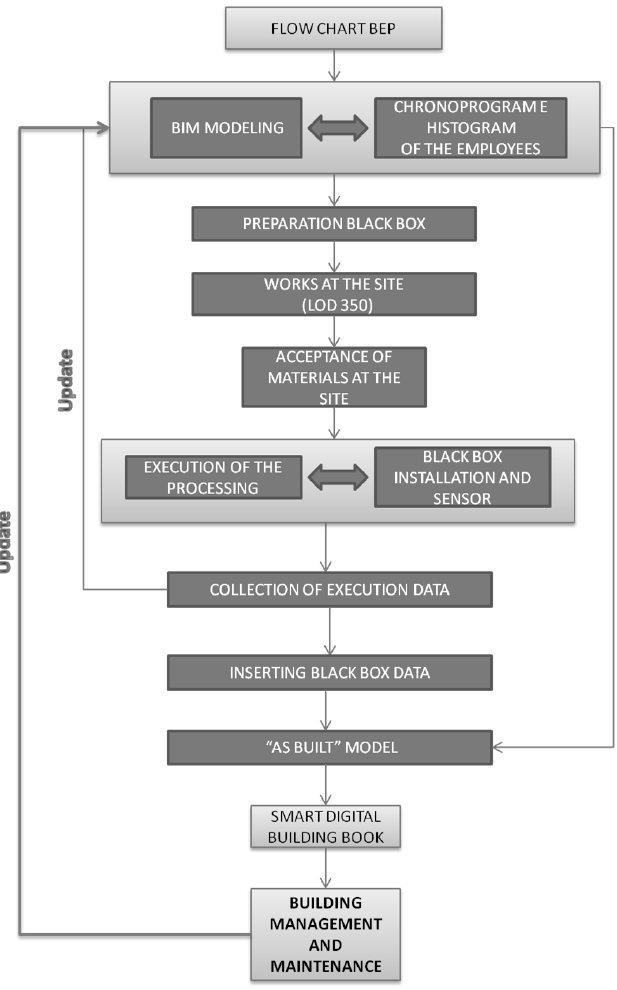
Figure 2: methodological path.